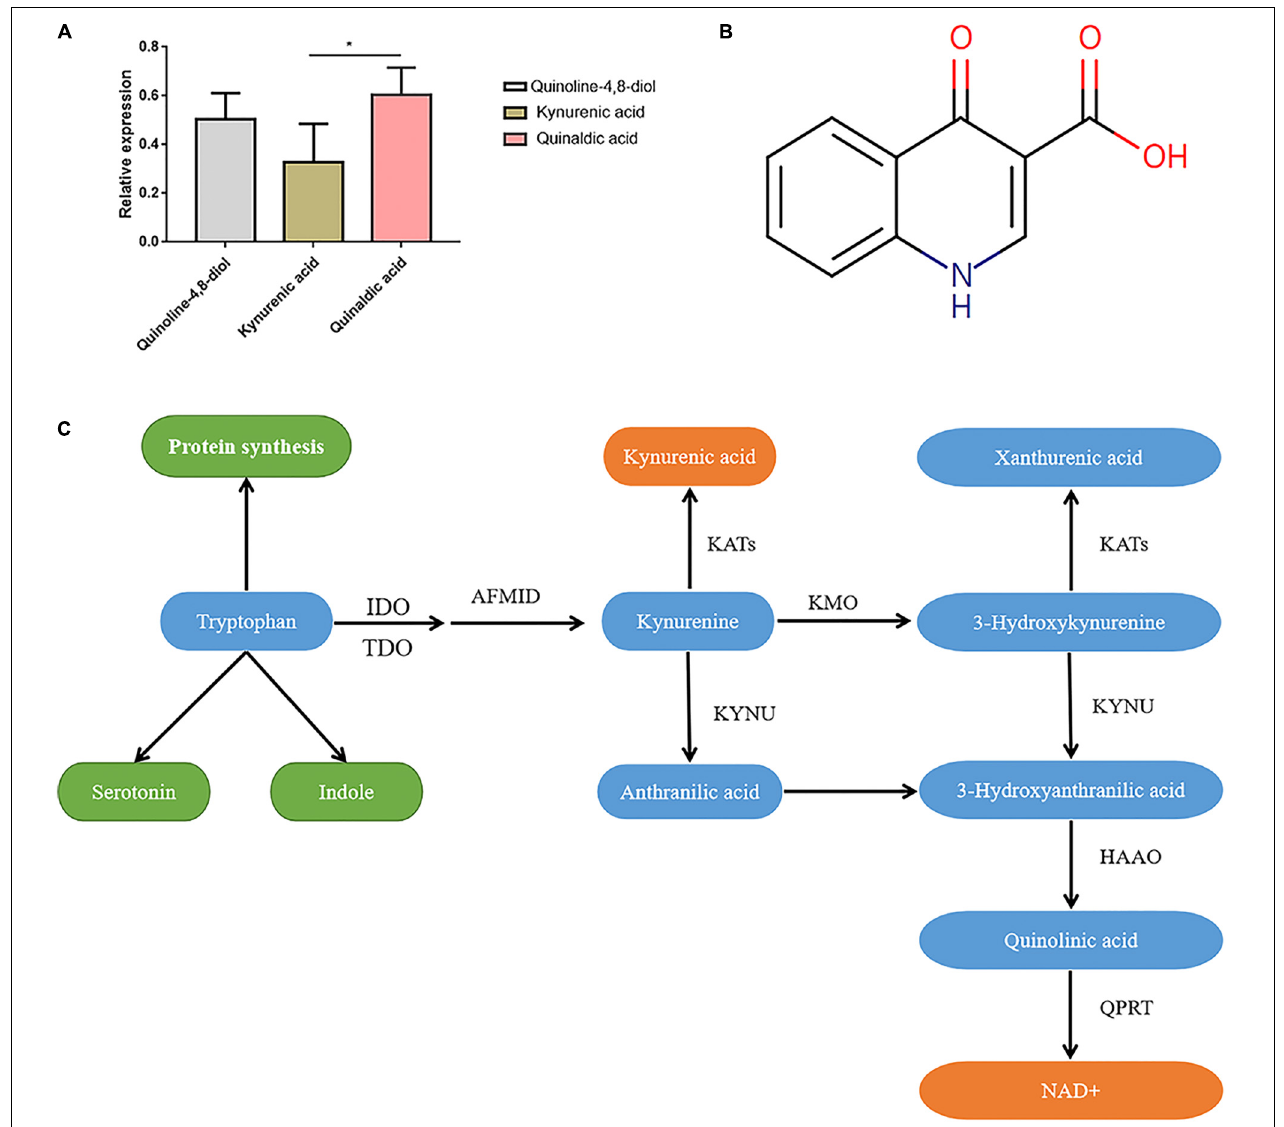
FIGURE 1 | Characteristics of kynurenic acid. (A) The relative expression of Kynurenic acid in the peripheral blood of patients with invasive C. albican infection is significantly lower than the content of other metabolites ( P < 0.05). (B) Kynurenic acid (HMDB0000715) is a kind of phosphatidic acid molecule with the molecular formula of C 10 H 7 NO 3 and a molecular weight of 189.1675 Da. (C) The kynurenine pathway is the primary route for tryptophan metabolism, with one of the biologically active metabolites being kynurenic acid (KynA). T, The Candida albicans infection group; C, The healthy control